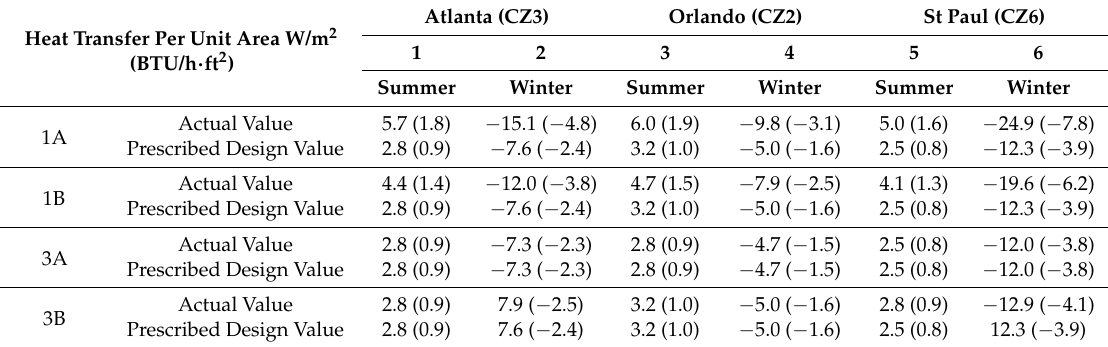
Table 8. Heat transfer per unit area (BTU/h · ft 2 ) in each assembly under three separate design conditions.